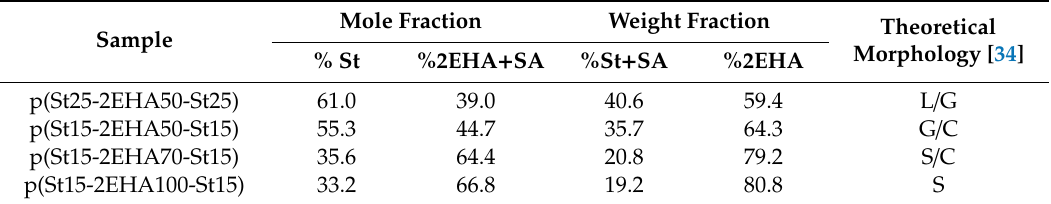
Table 4. Block copolymer composition results determined by 1 H NMR spectroscopy and theoretical morphology predicted based on AB block copolymers model. Mole Sample